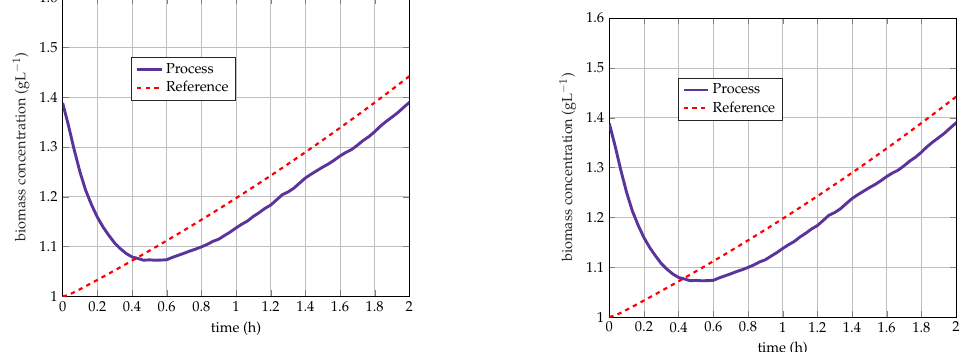
Figure 6. Biomass tracking with the full-order model ( Right ) and the reduced model ( Left ).